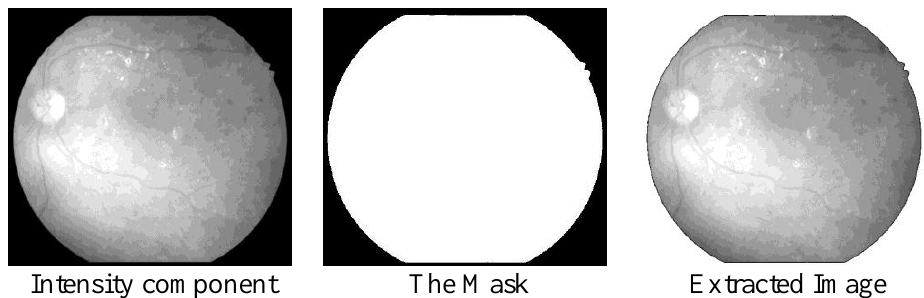
Fig.5: The mask creation performed to crop outer black region.